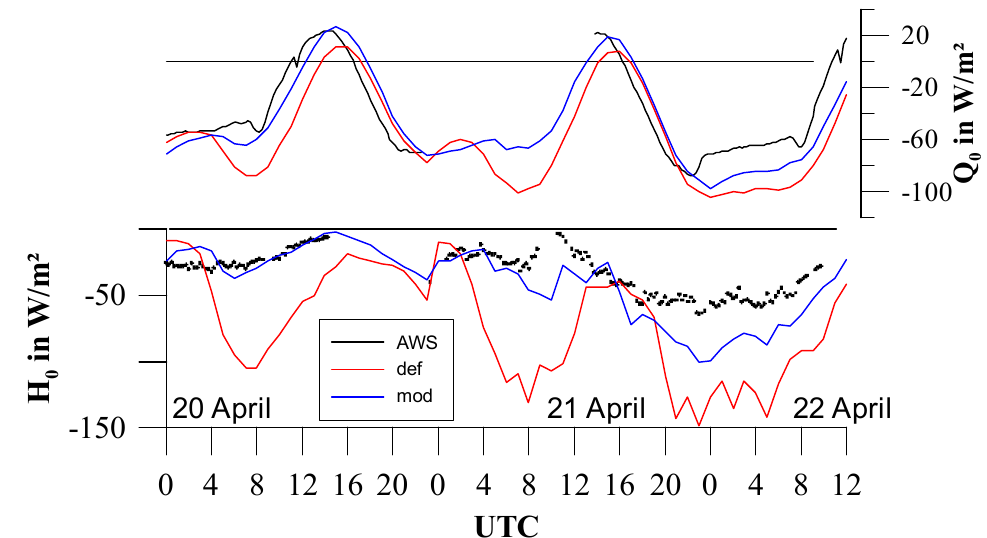
Figure 7. Temperature ( upper panel ), wind direction ( middle panel ) and wind speed ( lower panel ) for the period 00:00 UTC 20 April 1997 to 12:00 UTC 22 April 1997 for AWS A4 (15 min values, black), the standard turbulence parameterization (def, red), and the modified turbulence parameterization (mod, blue).